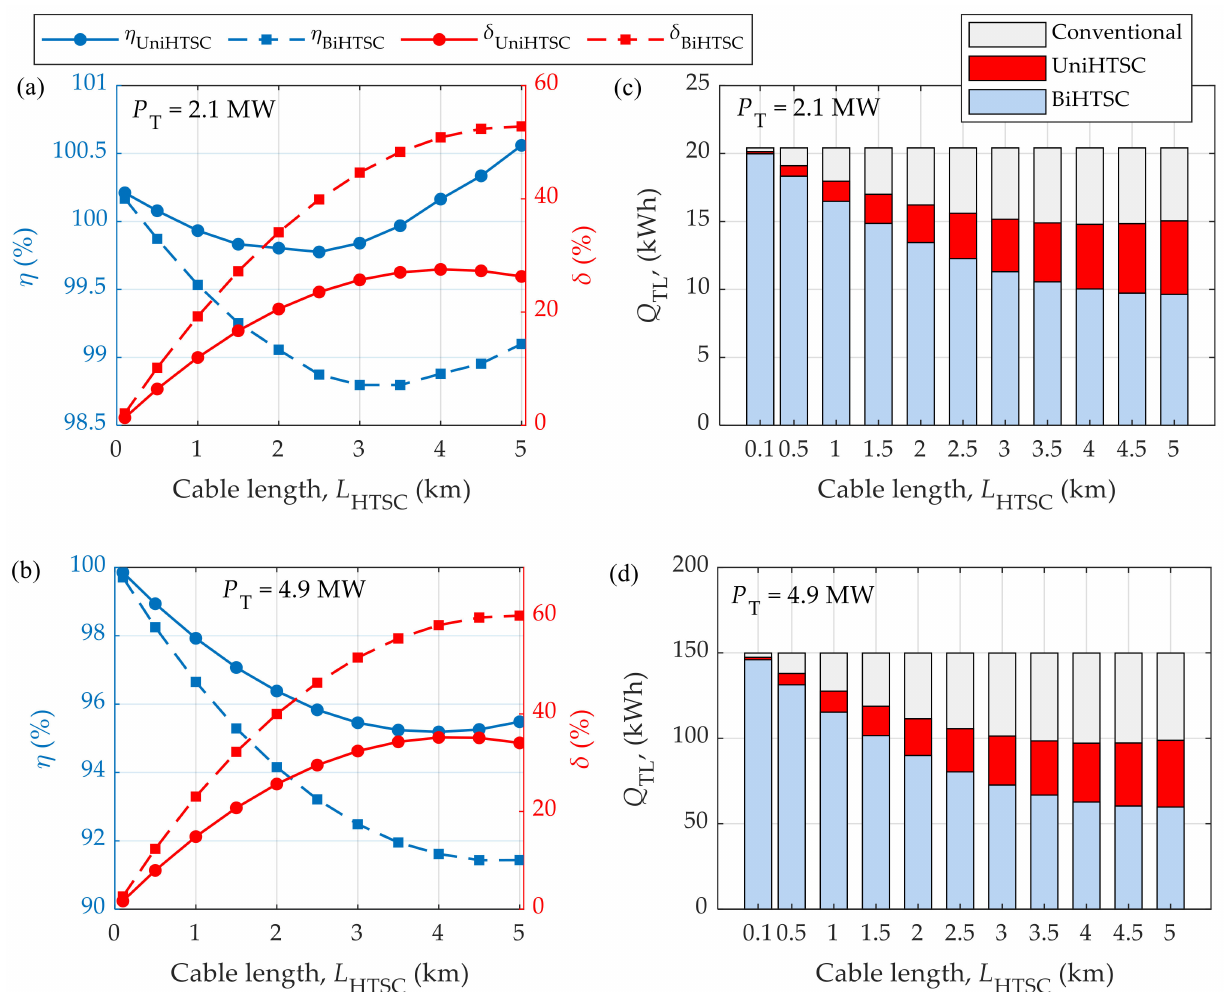
Figure 16. ( a , b ): on the left, the ratio η in percent of the energy consumption of a superconducting cable over the energy consumption of a conventional cable is shown; on the right, the relative energy consumed by the traction line δ is given in percent as a function of the length of the superconducting cable for train powers of 2.1 MW and 4.9 MW; ( c , d ) shows the energy consumed by the traction line Q TL as a function of the cable length for the same